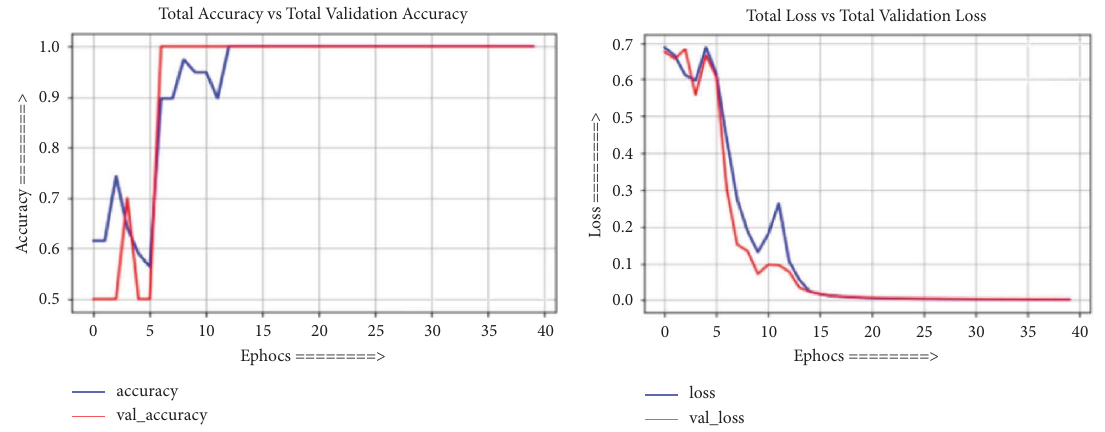
Figure 12: LRCN accuracy and loss value. Table 3: Evaluated results of up fall detection